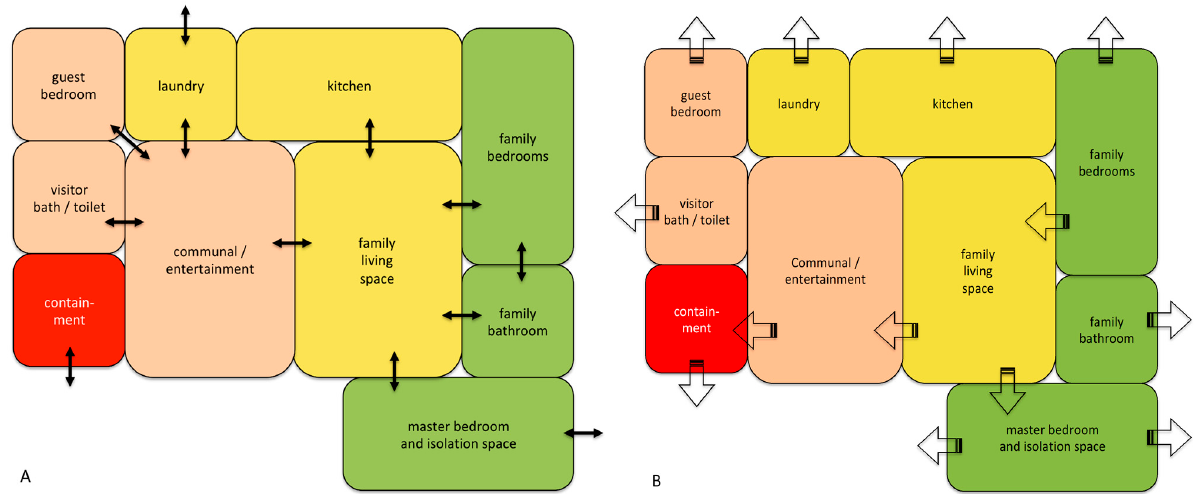
Figure 1. Conceptualizing internal zoning of domestic multi-bedroom dwelling spaces to compartmentalize exposure to infectious agents: ( A ) internal connectivity; ( B ) airflow directions. (Adapted from Ref. [31]).